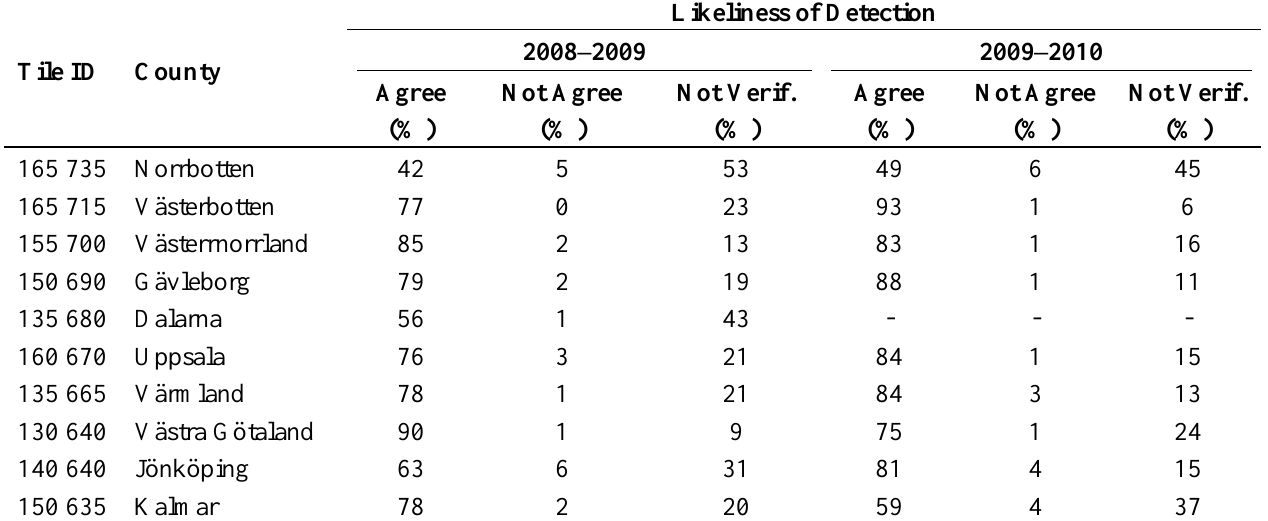
Table 3. Likeliness of agreement between pixels detected as change in pairs of ALOS PALSAR K&C strip images and SFA clear-felled areas for ten sites in Sweden for the time periods 2008–2009 and 2009–2010. Each site corresponds to a 50 × 50 km 2 area ( i.e. , an image